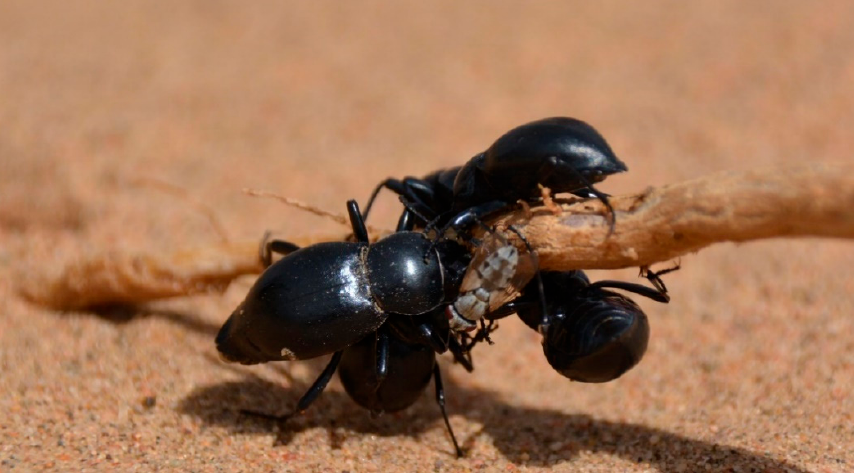
Figure 9. Anatolica mucronata feeding on damaged tissues of Artemisia sphaerocephala . Insects 2020 , 11 , x FOR PEER REVIEW